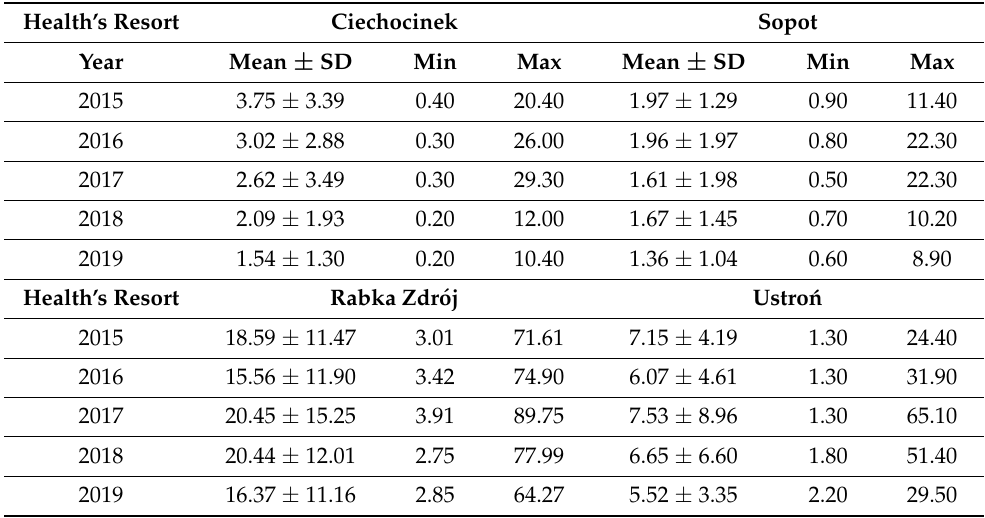
Table 3. Average annual values of SO 2 in the studied health resorts in 2015–2019. Health’s Resort